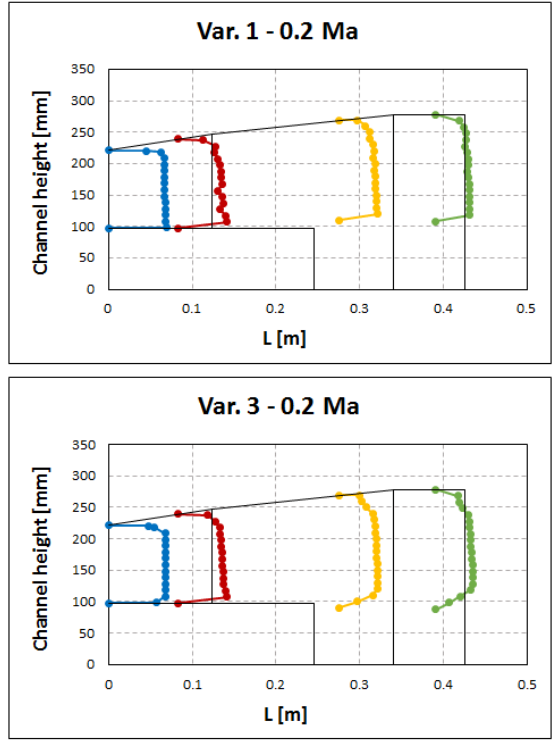
Fig. 15. Velocity profile in dependence on 𝐿 .